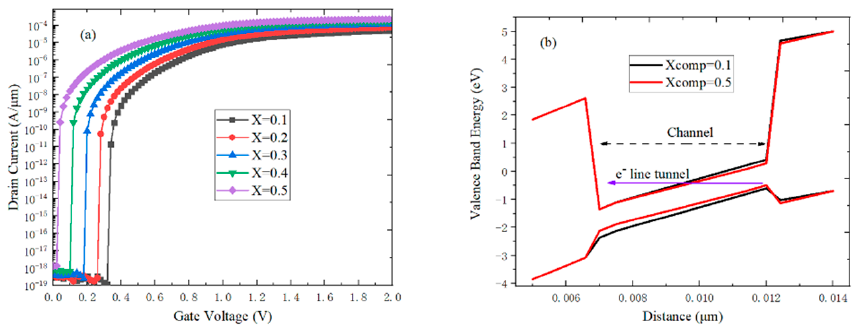
Figure 7. Influence of X Ge on ( a ) the transfer characteristic and ( b ) the on-state energy band from the top channel to the bottom channel.